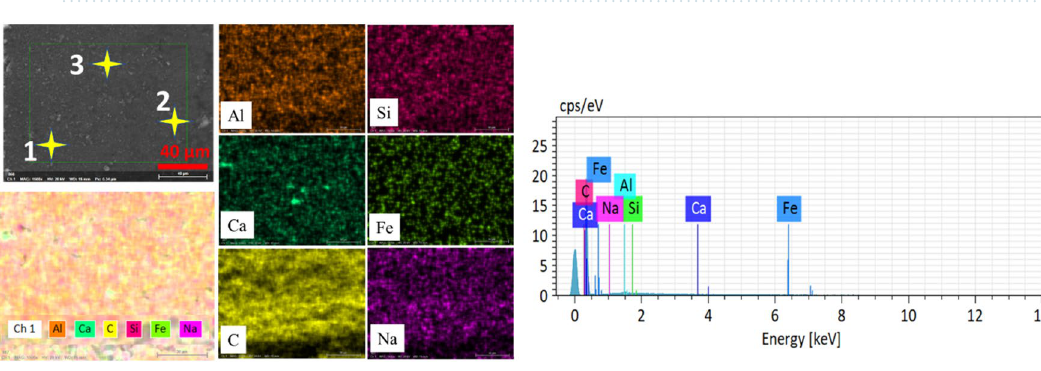
Figure 18. Spatter distribution with repetition rate at 200 ns. ( a ) 20 kHz, ( b ) 60 kHz, ( c ) 105 kHz, ( d ) 500 kHz and ( e ) 1000 kHz [fixed: 20W, 100 mm/s, 1 pass and 200 ns].